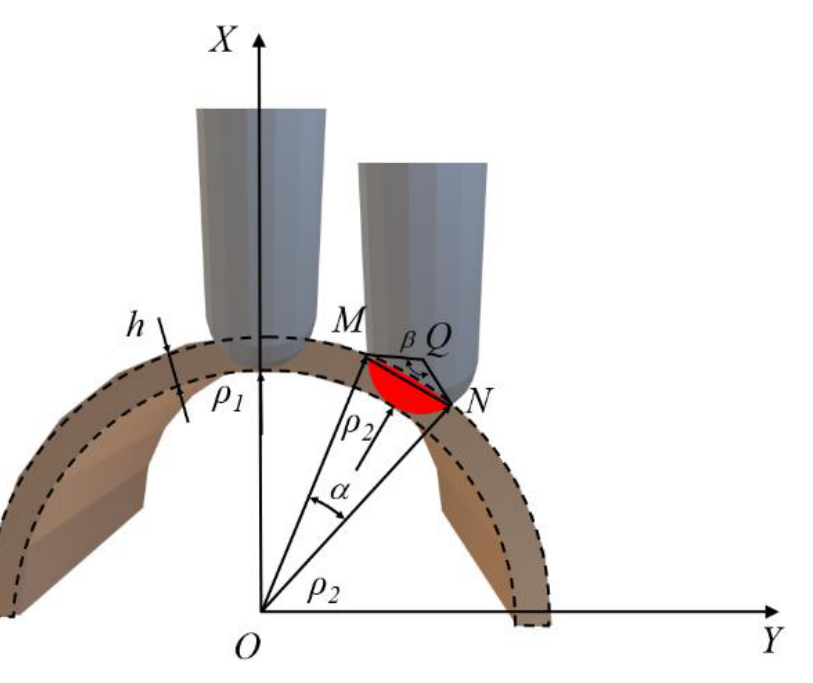
Figure 5. Ball-nose cutting contact area.